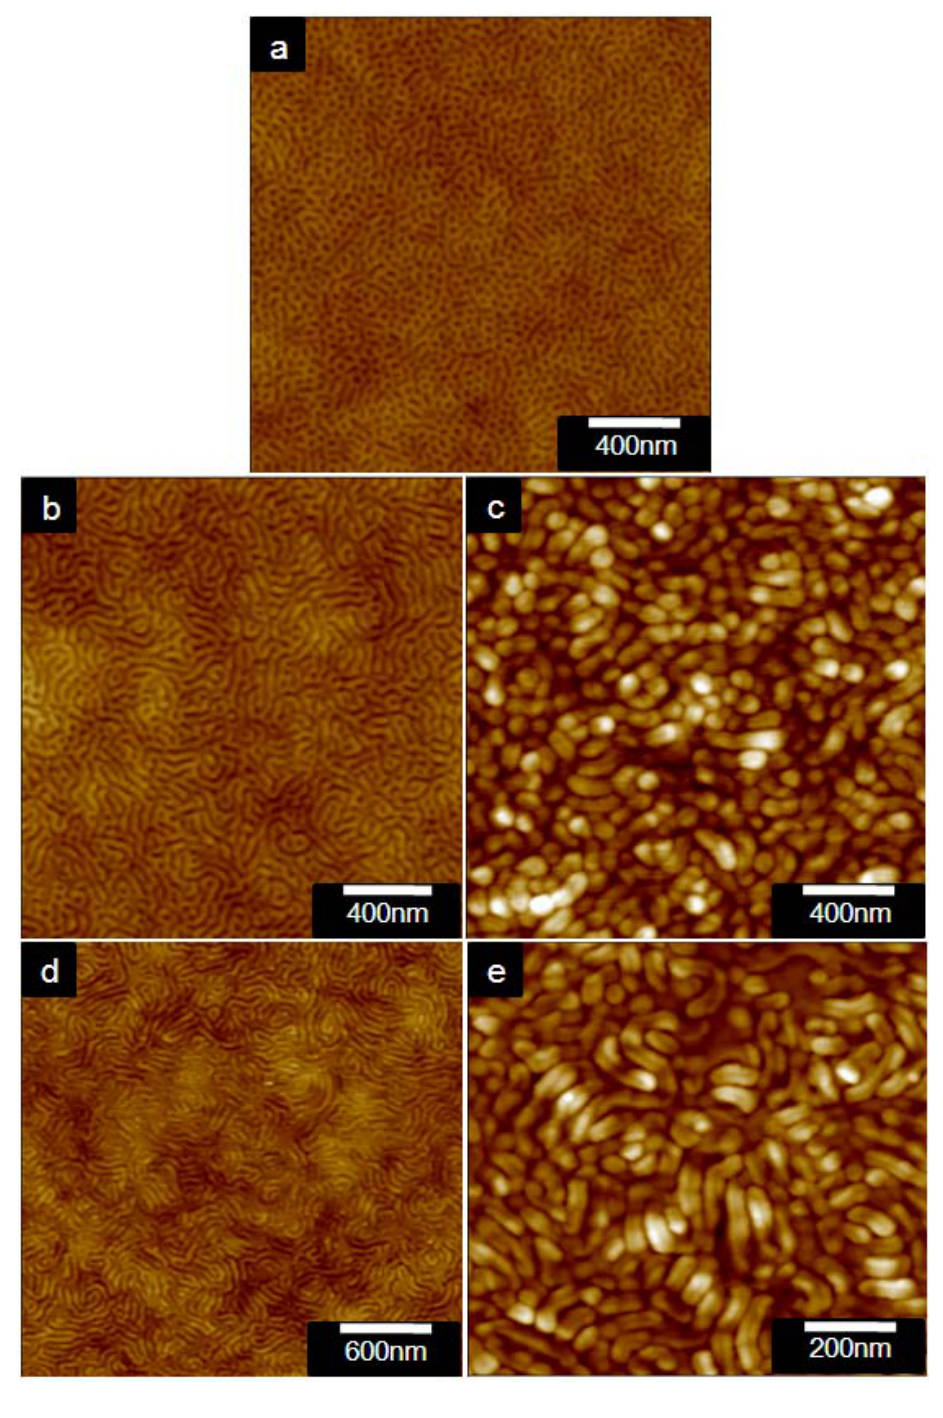
Figure S2 . Height contrast AFM images of the surfaces of PS- b -PEO/SiO containing (a) 10 vol% inorganic precursors; (b) 15 vol% inorganic precursors; (c) the identical film in (b) after removing the BCP templates; (d) PS- b -PEO/SiO containing 20 vol% inorganic precursors; (e) identical film in (d) after removing the BCP templates. The hybrid films were prepared from spin coating dioxane solutions. Ti/Si mass ratio is